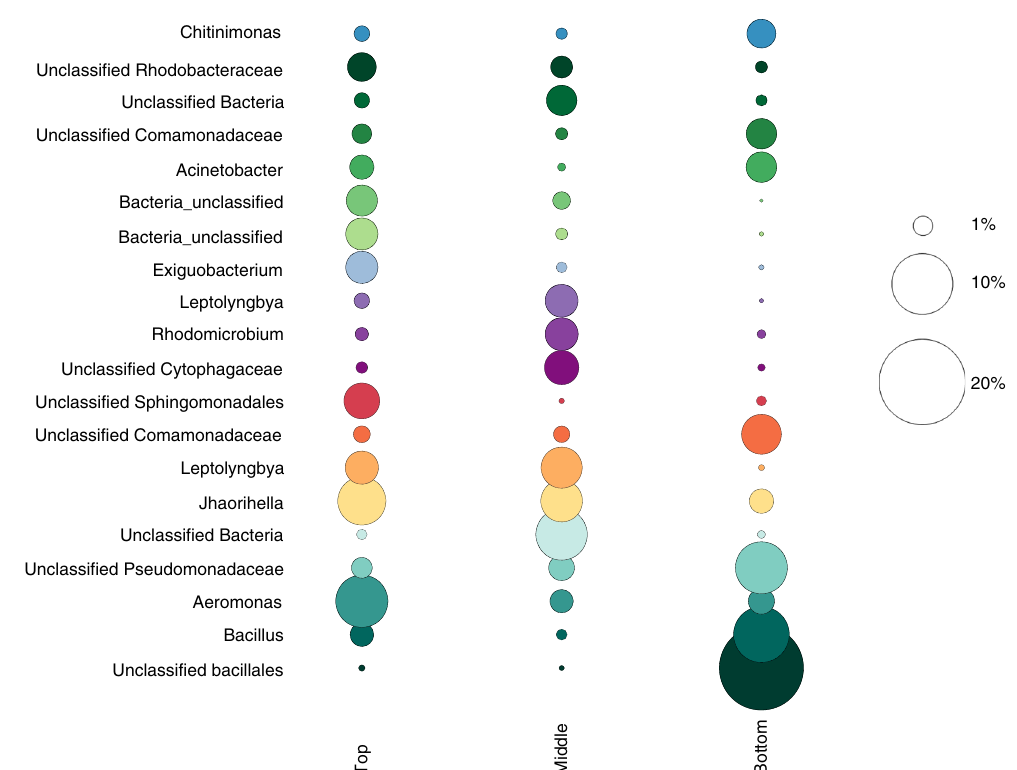
Fig. 4 Detailed composition of Balambano microbial mat community. The top 20 most abundant taxa (at 97% sequence identity, commonly accepted as de fi ning the species level), in the top, middle, and bottom microbial mat